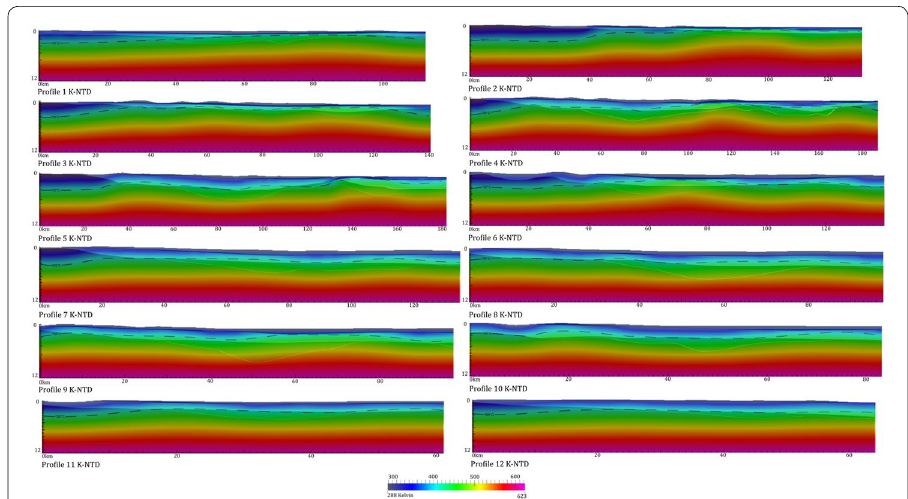
Fig. 10 Non-temperature-dependent (constant) thermal conductivity models for profiles 1–12. Temperature is given in degrees Kelvin (range from 288 to 623 K). K-NTD refers to K thermal conductivity and NTD non-temperature